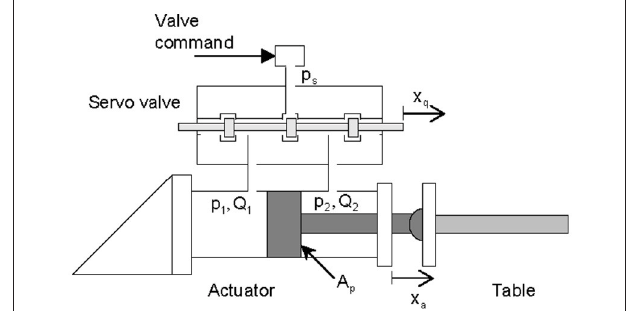
FIGURE 1 | Schematic of hydraulic